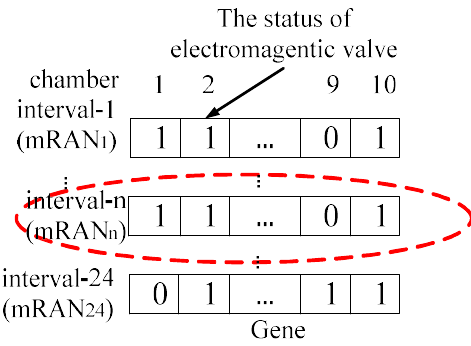
Figure 4. mRAN Figure 4. mRAN produced.